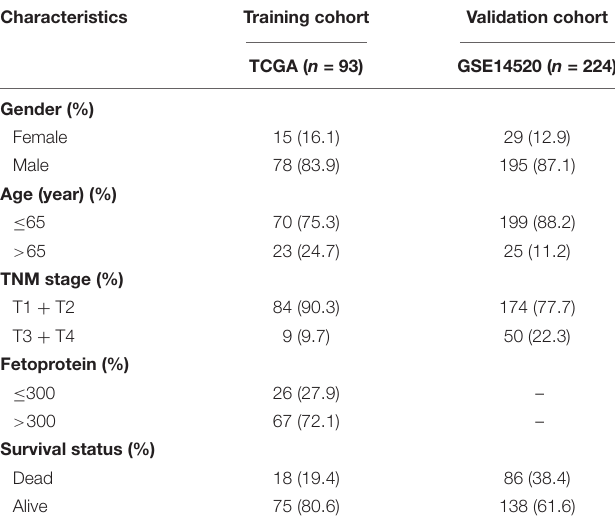
TABLE 1 | Characteristics of patient